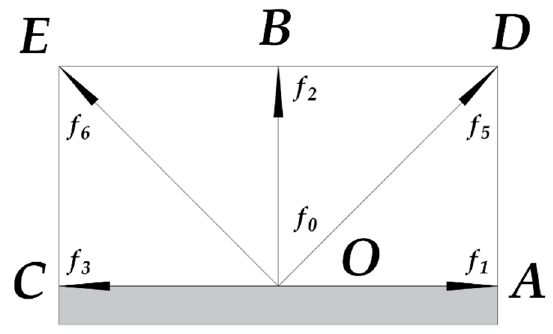
Figure 5. Non-equilibrium extrapolation format.